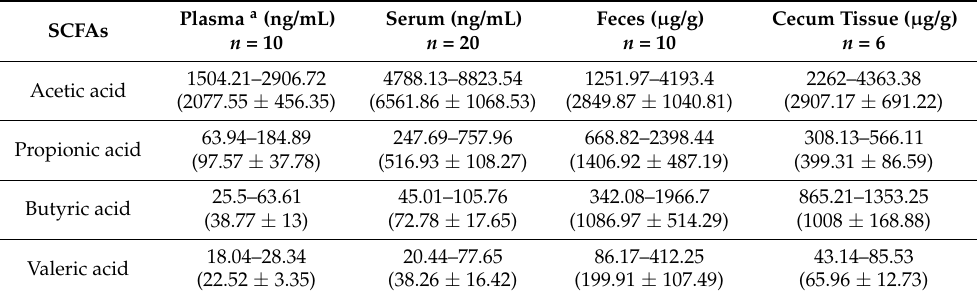
Table 5. Quantification results of the SCFA in the plasma, serum, feces, and mouse cecum tissue. Presented values are range with mean ± standard